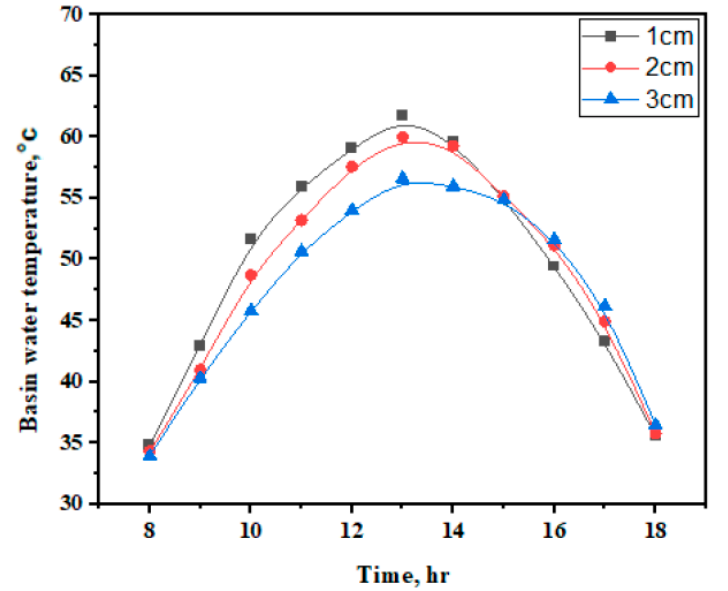
Figure 6. Daily variations of water temperature with respect to time. The heat and mass transfer (inside the still) are largely affected by the water depth and basin water temperature depending on Equations (3)–(8). The daily variations in the heat transfer coefficients by convection and evaporation inside the still are depicted in Figures 7 and 8. As seen from the figures, at various water depths the rate of heat transfer by evaporation is higher than the rate of heat transfer by convection under the same operating conditions. It is revealed that the still with 1 cm water depth gives the highest evaporation heat transfer coefficient (32 W/m 2 · k) at 13:00 p.m. and then decreases to (7.7 W/m 2 · k)